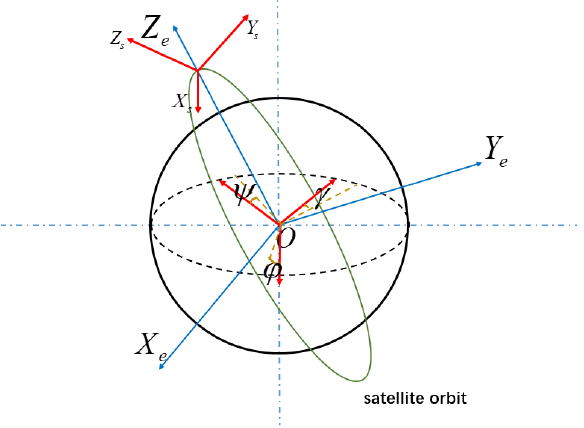
Figure 3. The celestial coordinate system with the center of the Earth as the origin.